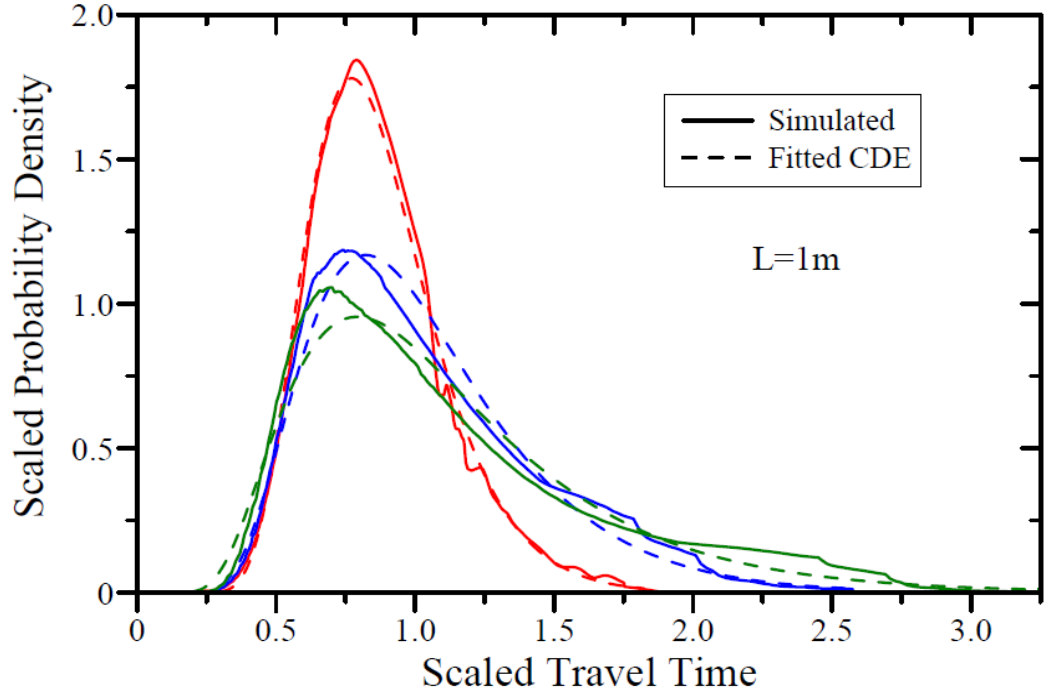
Figure 6. Scaled travel time at a horizontal control plane (CP) located at soil depth, L = 1 m, for the different scenarios examined.